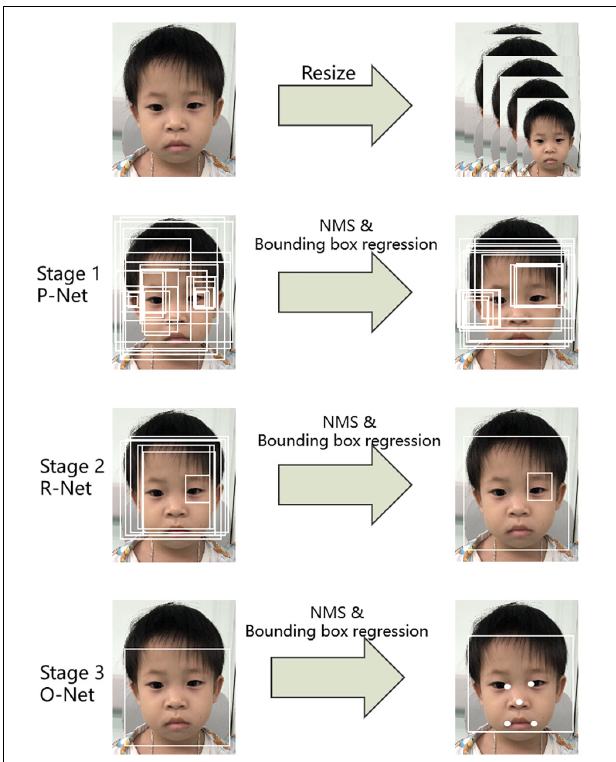
FIGURE 3 | Pipeline of the multi-task convolutional neural network (MTCNN).